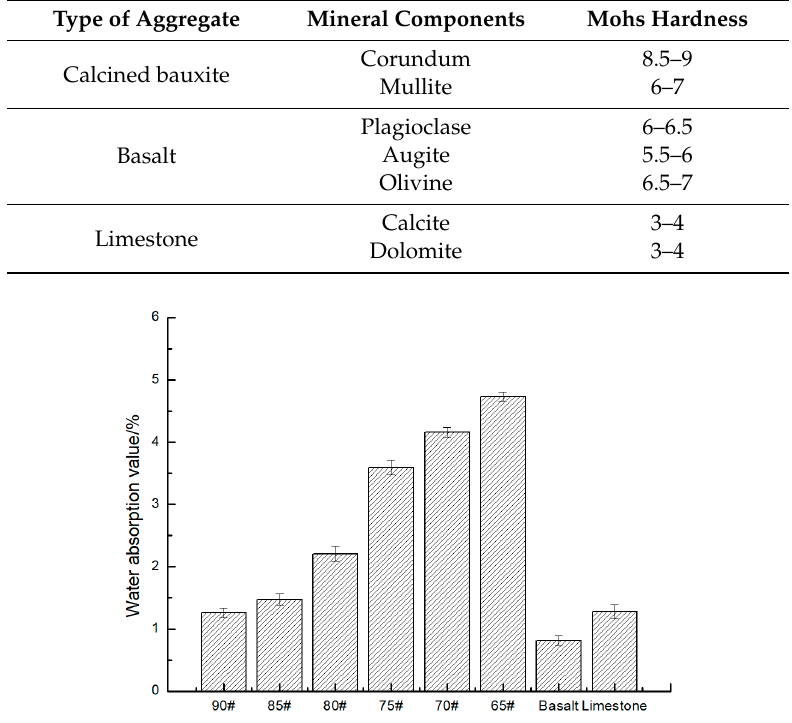
Figure 6. Water absorption values of different aggregates.